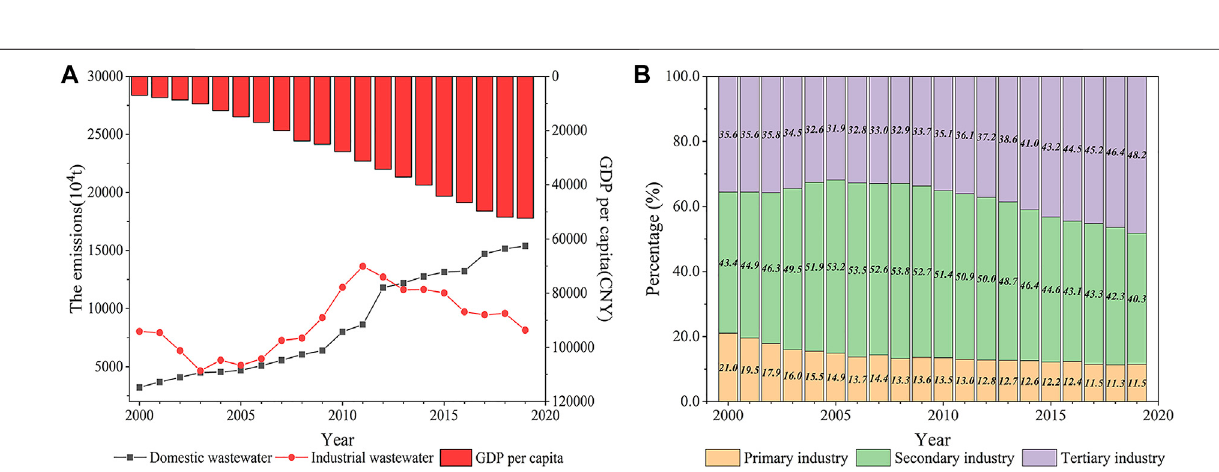
FIGURE 7 | (A) GDP per capita, industrial and domestic wastewater emissions and (B) industrial structural change in the study area (2000 – 2019).